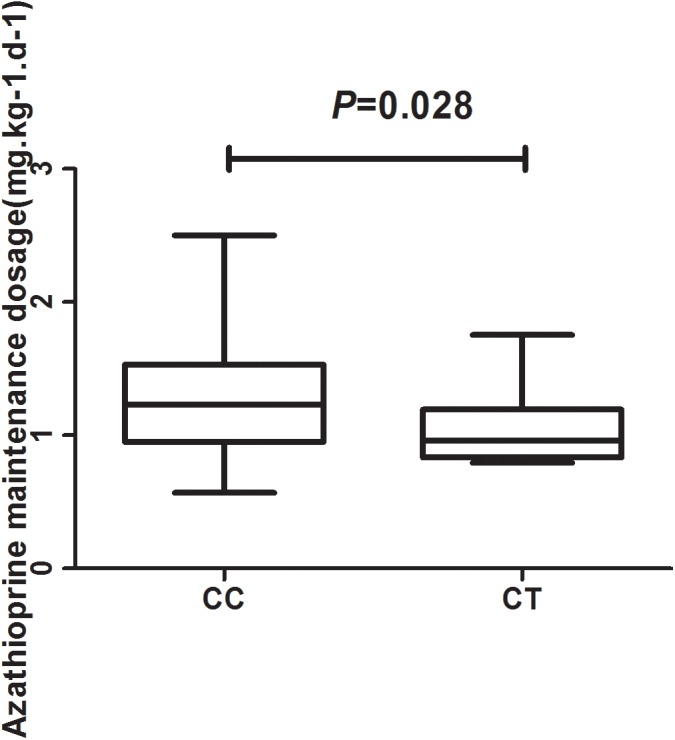
The median maintenance dosages for patients with rs116855232 CC and CT genotypes were 1.23 (0.95, 1.53) mg ⋅ kg−1 ⋅ d−1 and 0.96 (0.83, 1.19) mg ⋅ kg−1 ⋅ d−1, respectively (P = 0.028).